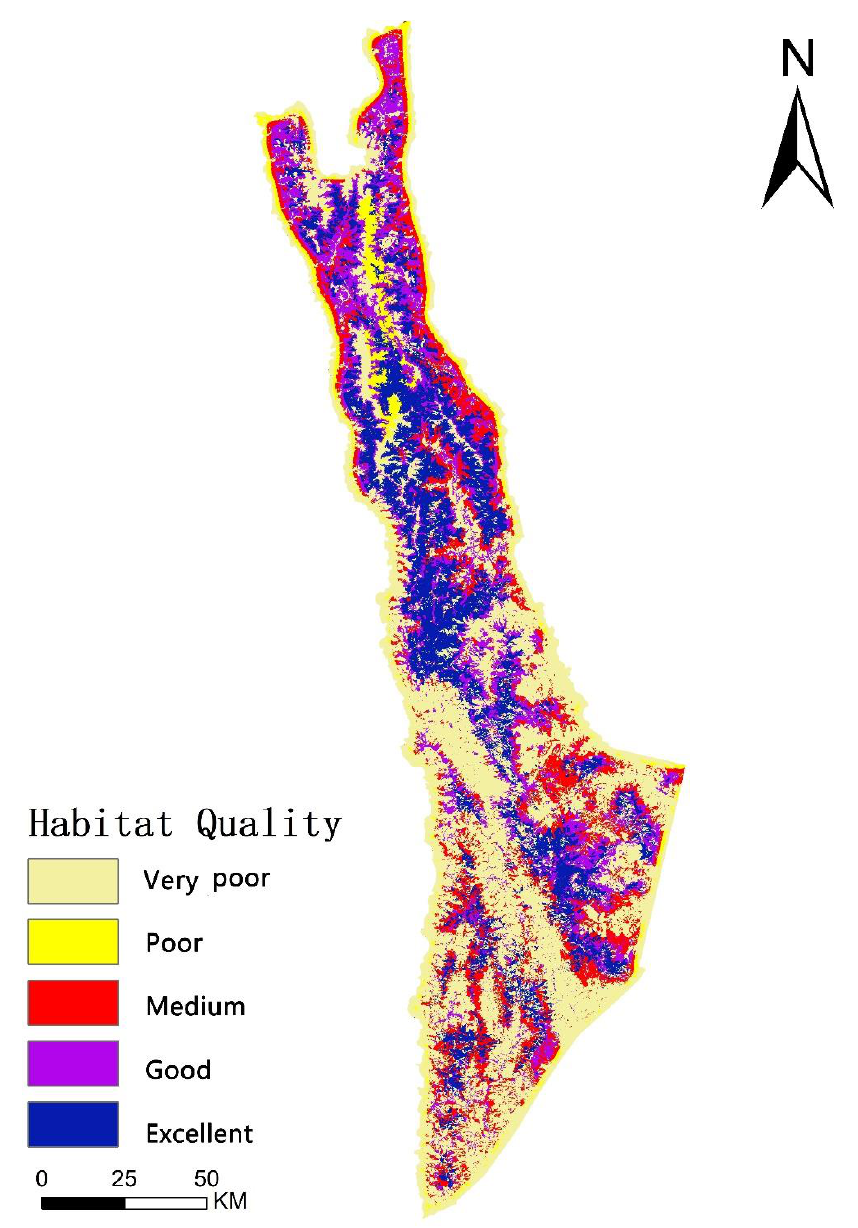
Figure 4. Spatial distribution pattern of habitat quality in 2018.